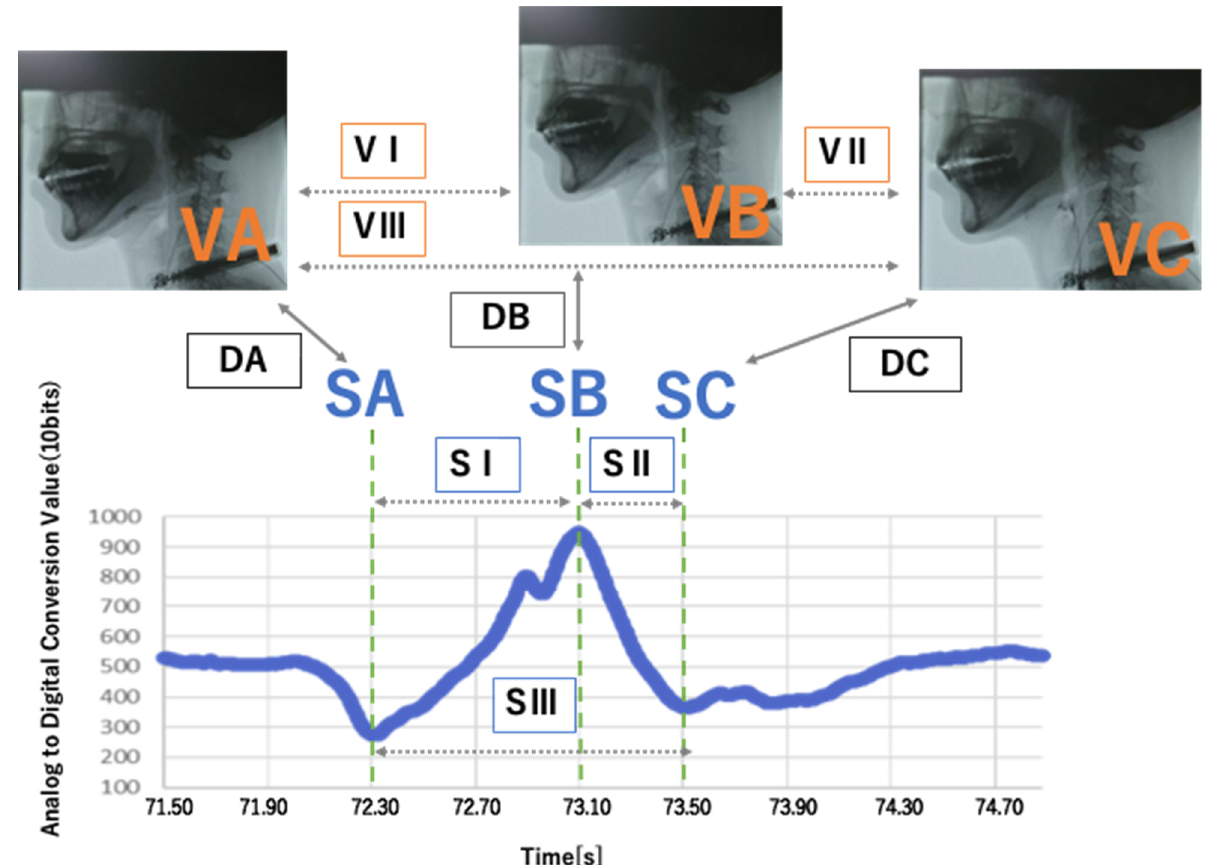
Figure 2. Correspondence between soft palate movement and sensor waveform.